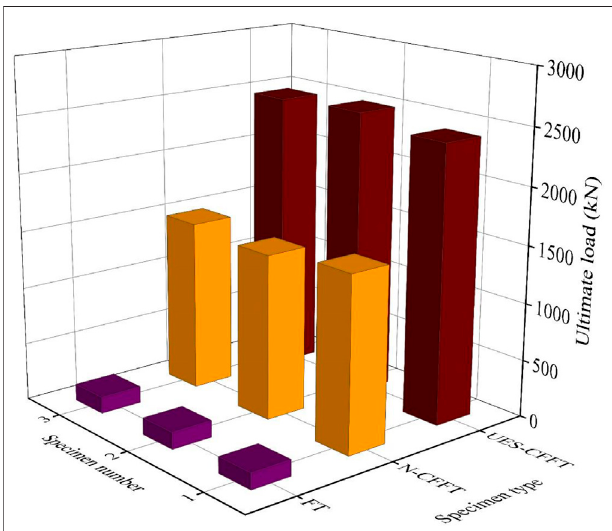
FIGURE 6 | Ultimate load comparison of the three types of specimens.